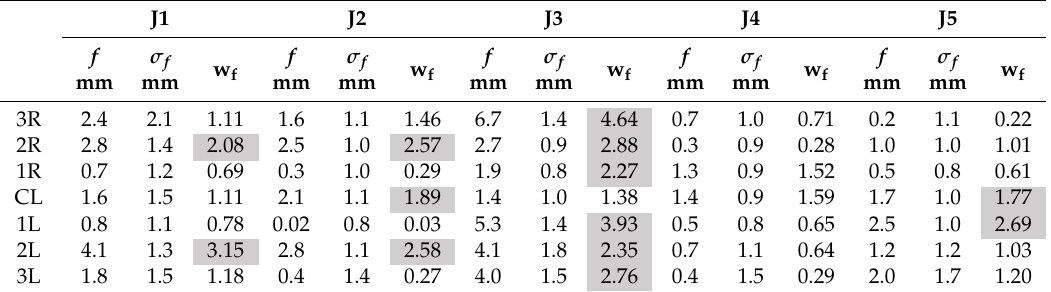
Table 8. Faulting, RMSE and ratio fault/ σ ∆ sx,dx computed using the segment, which linearly